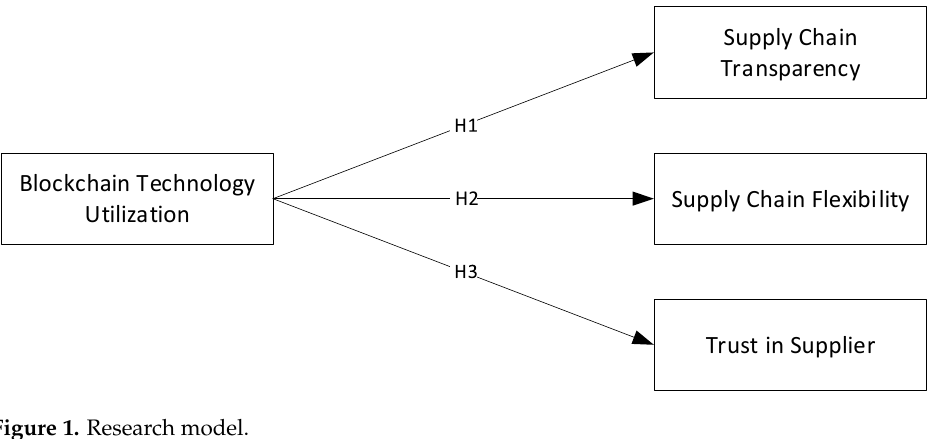
Figure 1. Research